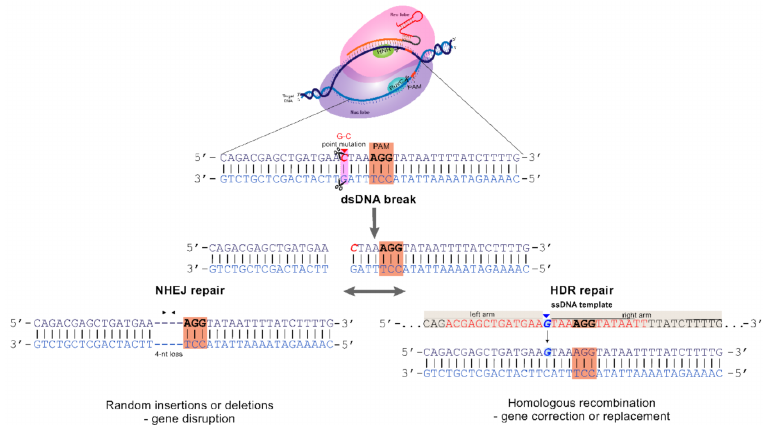
Figure 3. DNA repair mechanism. Mechanisms of gene editing mediated by NHEJ and HDR after CRISPR/Cas-induced double-strand